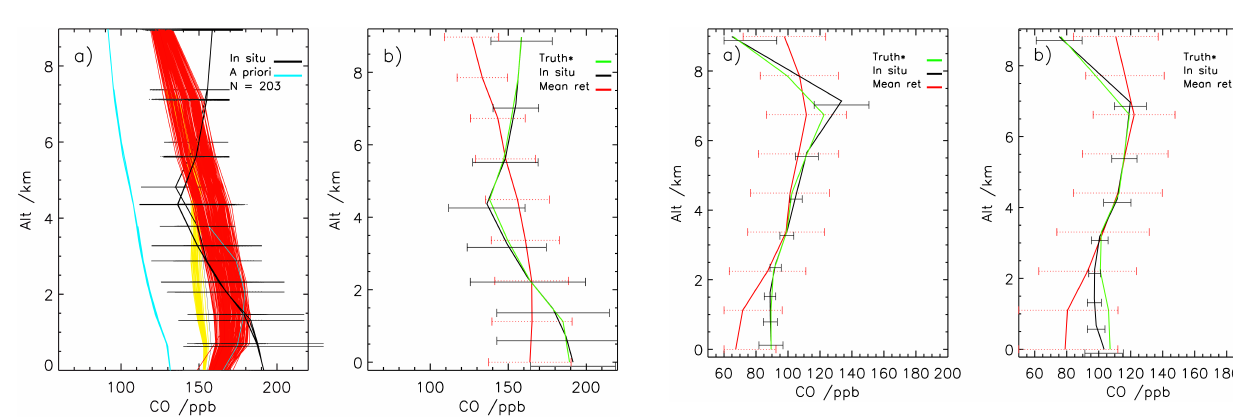
Figure 11. (a) A total of 203 individual carbon monoxide concen- tration retrieval profiles across flight B290 colour coded for ob- server (flight) altitude. Retrieval uncertainty (total error) is shown as the dotted bars in each case. In situ and a priori profiles are also shown as per legend. (b) Mean profiles from flight B290 for re- trieved (red), in situ measured (black), and in situ average convolved with ARIES averaging kernels (green). The in situ 1 σ measurement variability is shown as black bars at each binned vertical level and the root mean square retrieval uncertainty (total error) is shown by the red bars.